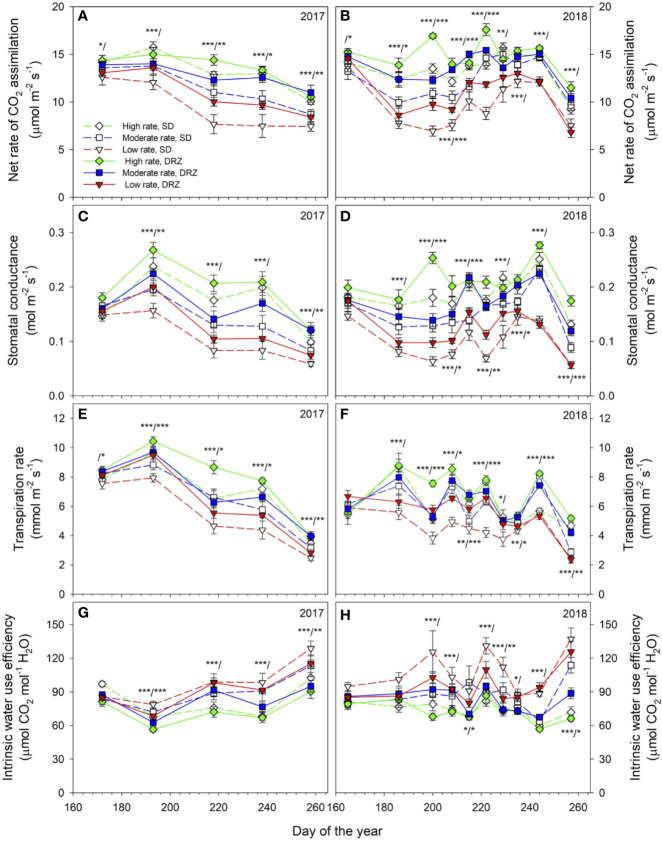
Leaf gas exchange under surface drip (SD, dashed lines) and direct root-zone (DRZ, solid lines) irrigation in 2017–2108. (A, B): net CO2 assimilation rate (A, µmol m−2 s−1); (C, D): stomatal conductance (gs, mol m−2 s−1); (E, F): transpiration rate (E, mmol m−2 s−1); and (G, H): intrinsic water use efficiency (WUEi, µmol CO2 mol−1 H2O). Three irrigation rates were set based on crop evapotranspiration (ETc) for Cabernet Sauvignon: Diamonds with green lines, squares with blue lines, and triangles with red lines represent irrigation rates at high (0.75–0.80 ETc), moderate (0.60–0.65 ETc) and low (0.45–0.50 ETc), respectively. Asterisks on the left side of the slash indicate statistically significant differences between effects of irrigation rate, and ones on the right side of the slash indicate statistically significant differences between effects of irrigation method. *, ** and *** represent statistical differences at P ≤ 0.05, 0.01 and 0.001, respectively. Error bars represent standard error (n = 9).